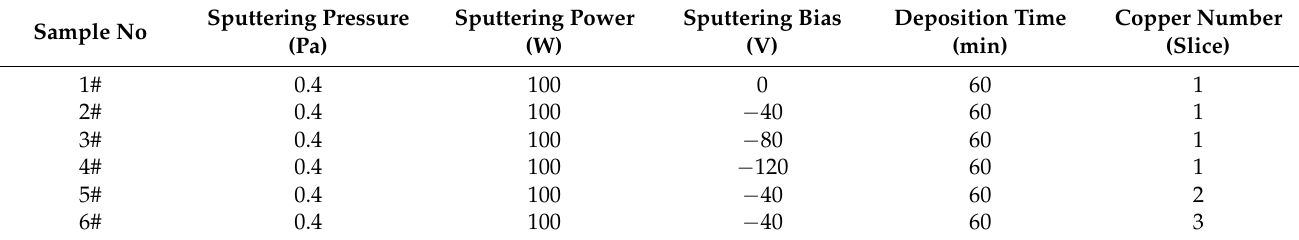
Table 1. The preparation parameters of various Cu/Ti